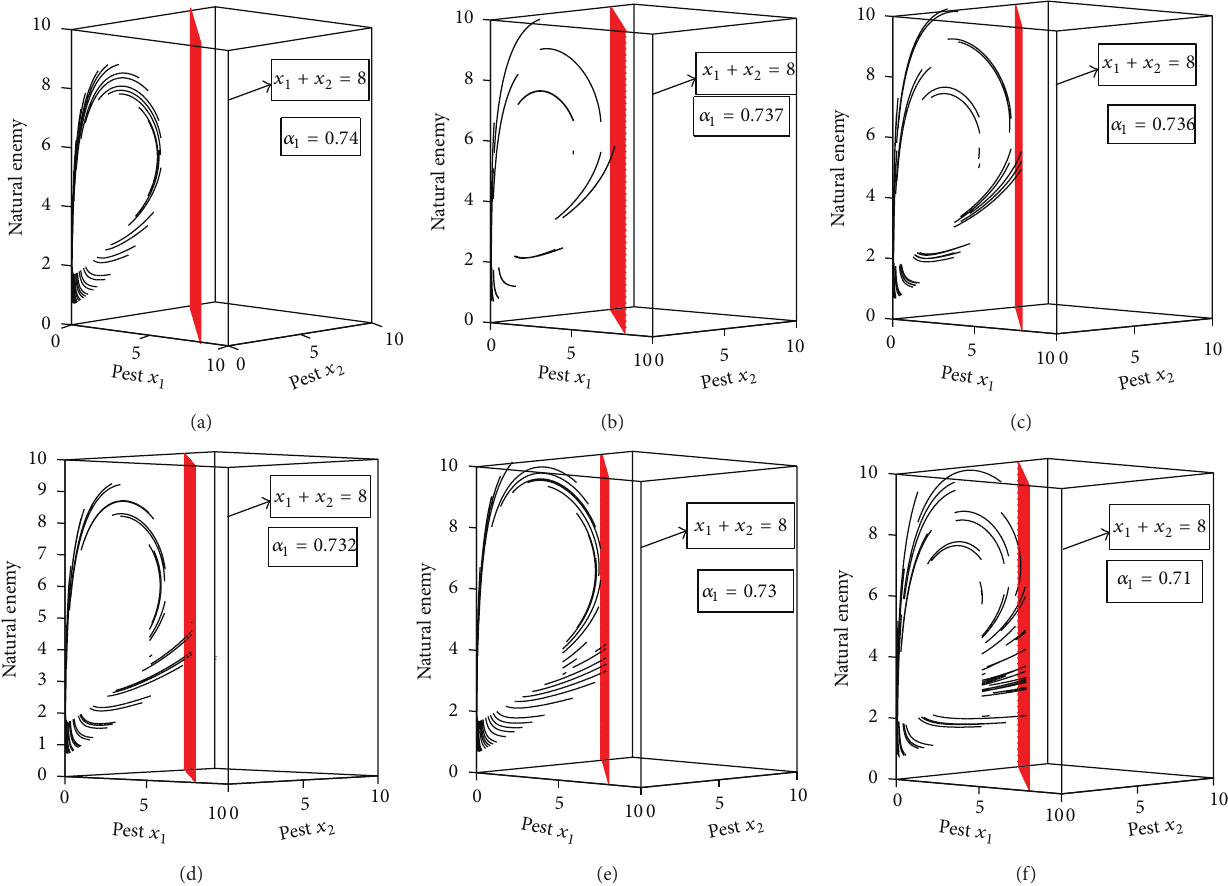
Figure 8: The effects of ET and 𝛼 1 of model (11) on the control strategies. The initial values are 𝑥 1 = 1.3 ; 𝑥 2 = 1.5 ; and 𝑦 = 5 , and parameters are fixed as follows: 𝛿 1 = 0.65 , 𝛿 2 = 0.7 , 𝛿 3 = 0.95 , 𝜎 = 1 , ET = 8 , 𝑇 = 4 , 𝑎 1 = 0.75 , 𝑎 2 = 0.85 , 𝛼 2 = 0.85 , 𝑐 1 = 0.2 , 𝐾 1 = 20 , 𝑏 = 0.25 , 𝑐 = = 0.85 , 𝐾 = 30 , 𝑐 = 0.65 , 𝑊 = 0.45 , 𝑊 = 0.75 , 𝑑 = 0.25 , and 𝑟 = 1.2 0.3 , 𝐴 2 2 2 1 2